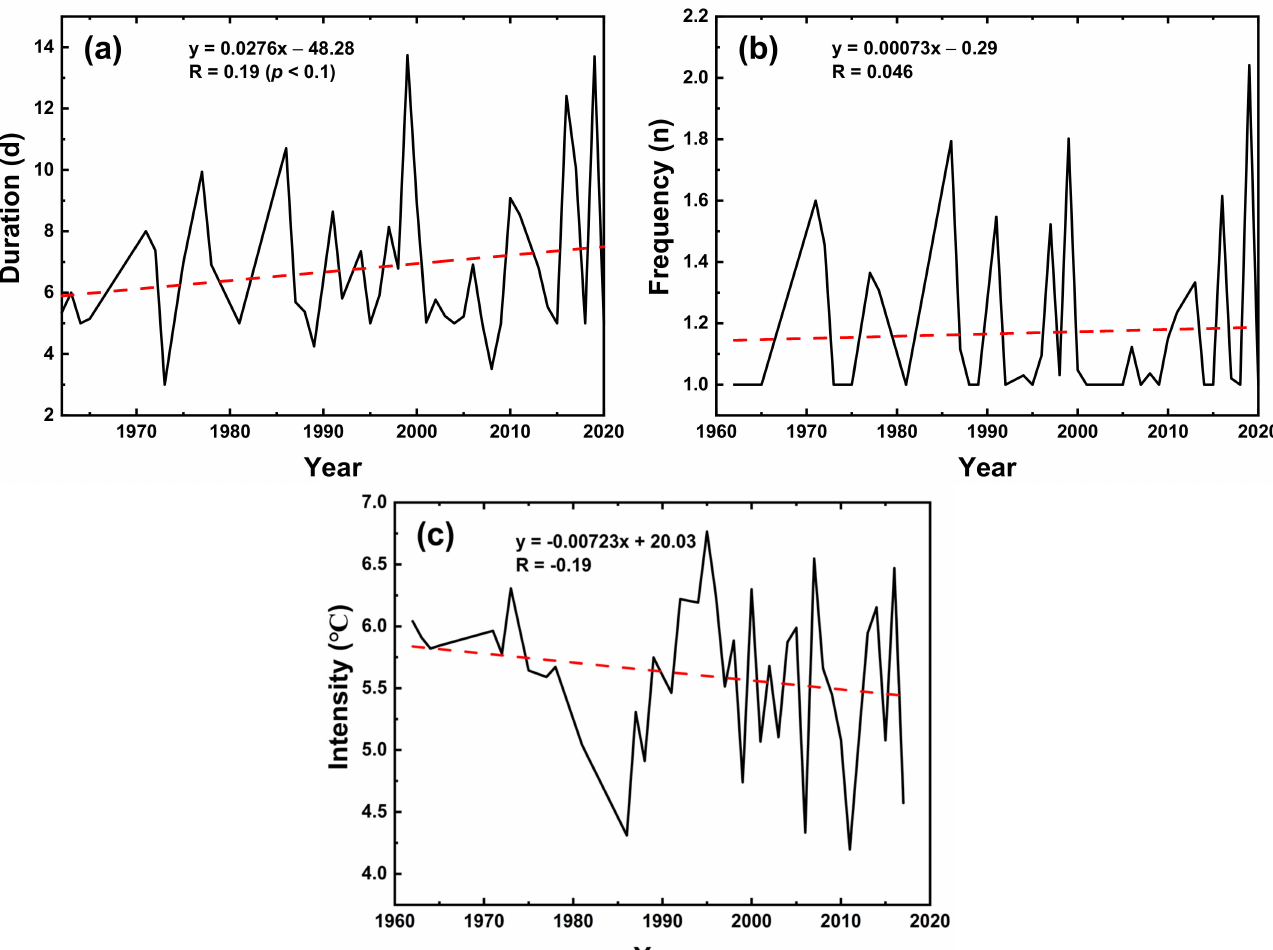
Figure 2. Temporal variation characteristics of duration ( a ), frequency ( b ) and intensity ( c ) of high- temperature heatwaves in Hexi Oasis from 1962 to 2020. The black lines are annual average tempera- tures and the red dotted lines are